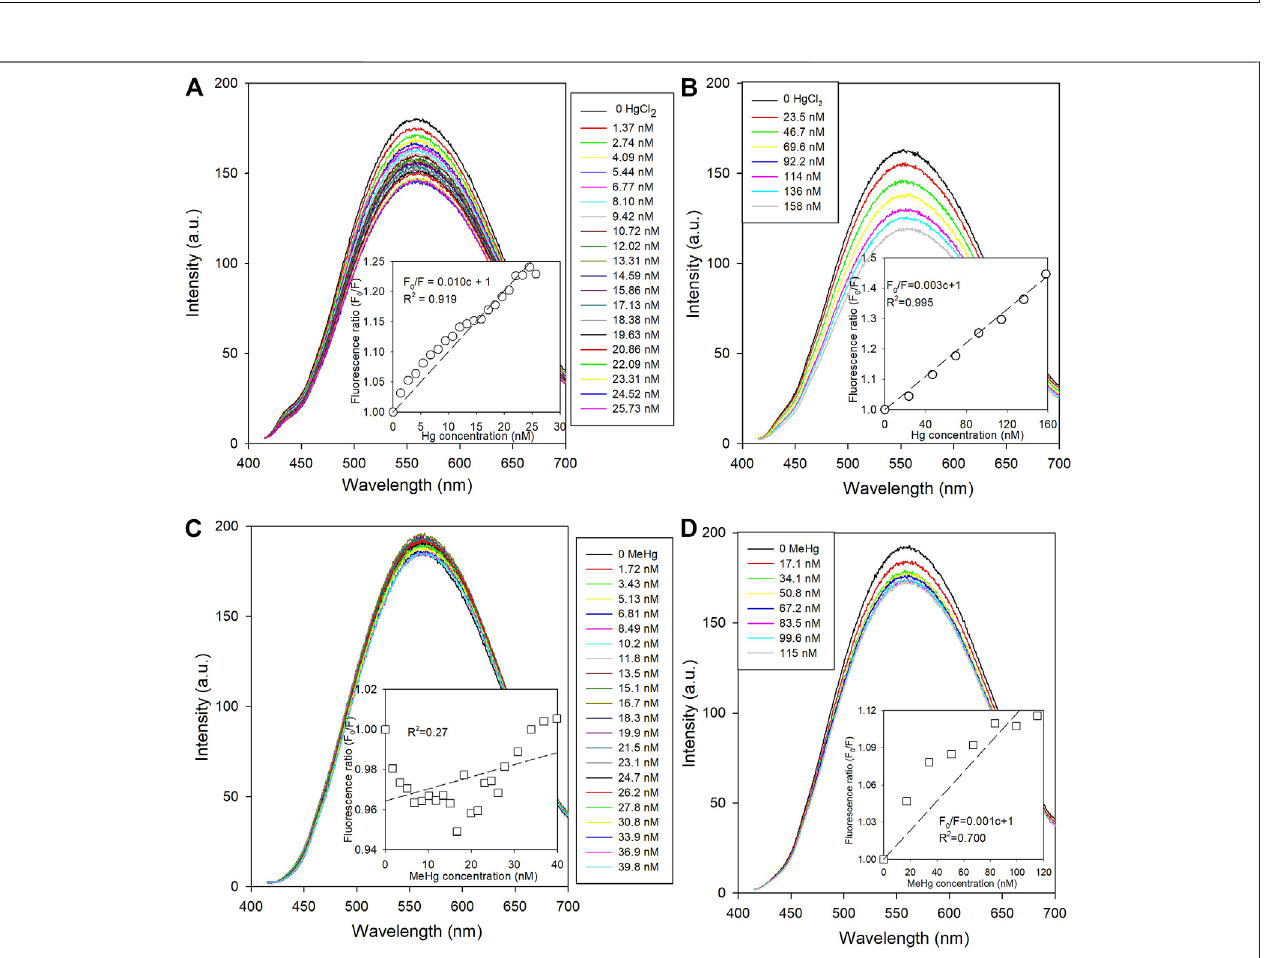
FIGURE2| Thechangeof fl uorescencespectraofL-cysteinecapped CdSeNPswithmercury species quenching(Ex (cid:1) 400 nm). Theinserted diagramsshow the Stern-Volmer fi ttings plotted with the concentrations of quenchers and the fl uorescence intensity ratios at ∼ 560 nm. (A) the low-level with HgCl 2 concentration of 0 – 26 nM; (B) the high-level with HgCl 2 concentration of 0 – 160 nM; (C) the low-level with MeHg concentration of 0 – 40 nM; and (D) the high-level with MeHg concentration of 0 – 115 nM.